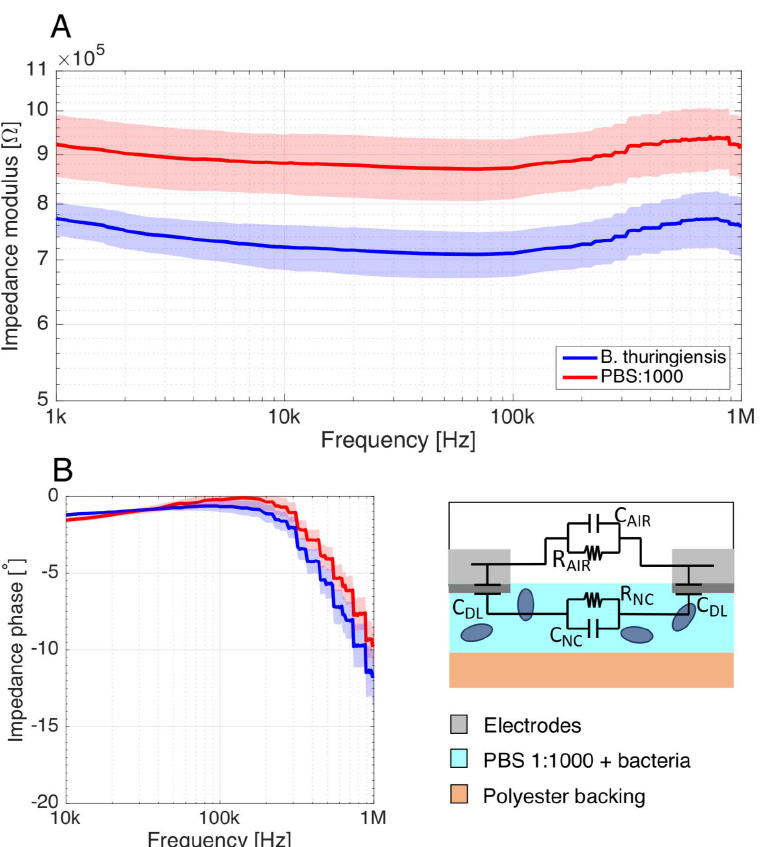
Figure 8. ( A ) Impedance measurements performed on nitrocellulose (NC) membrane as seen by the IDE, with and without bacterial cells in PBS:1000 buffers. The impedance modulus presents a constant impedance shift representing a decrease in the solution resistance. ( B ) Since a direct conduction path exists between their electrodes, the impedance seen by the IDE has a character that is rather resistive as expressed by the highly resistive phase over a large spectrum. Number of samples: 12 from two independent experiments. Shaded area surrounding the measurements curves: standard deviation ( σ ).